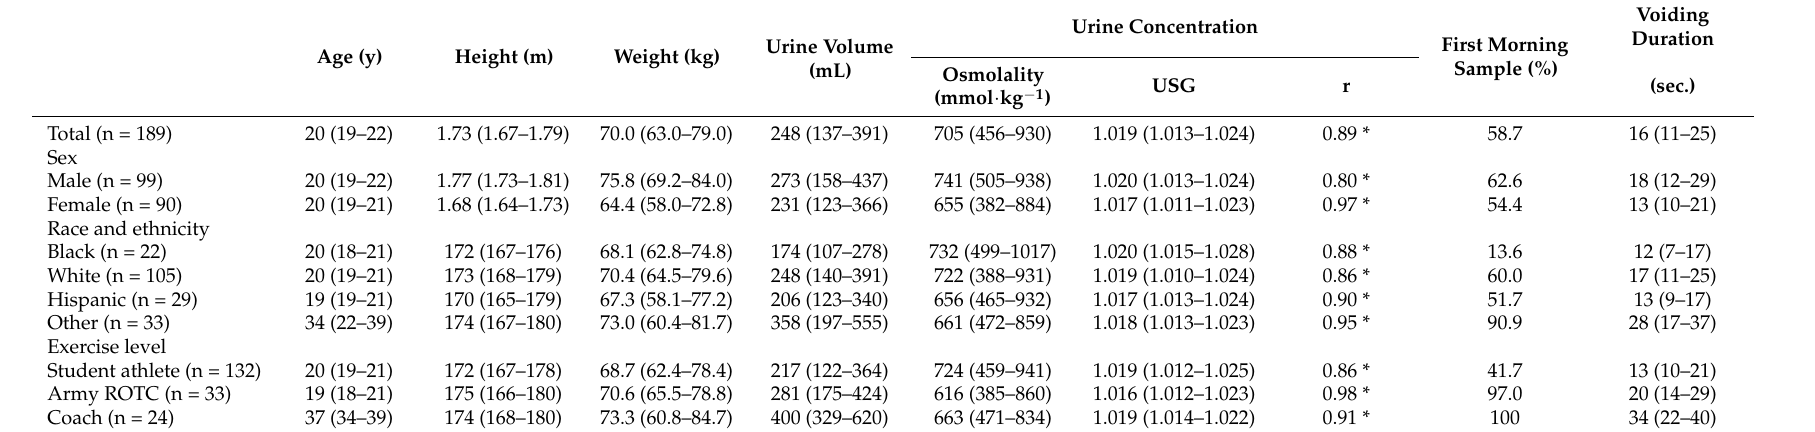
Table 1. Participant and urine sample characteristics.